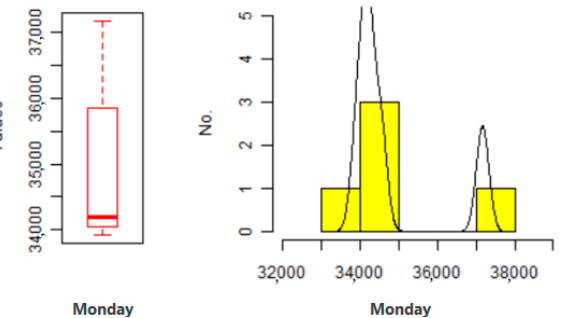
Figure 12. Before a variance of excluding the noise data on Monday: In the graph, the vertical axis is the day of the week, and the horizontal axis is the traffic volume.